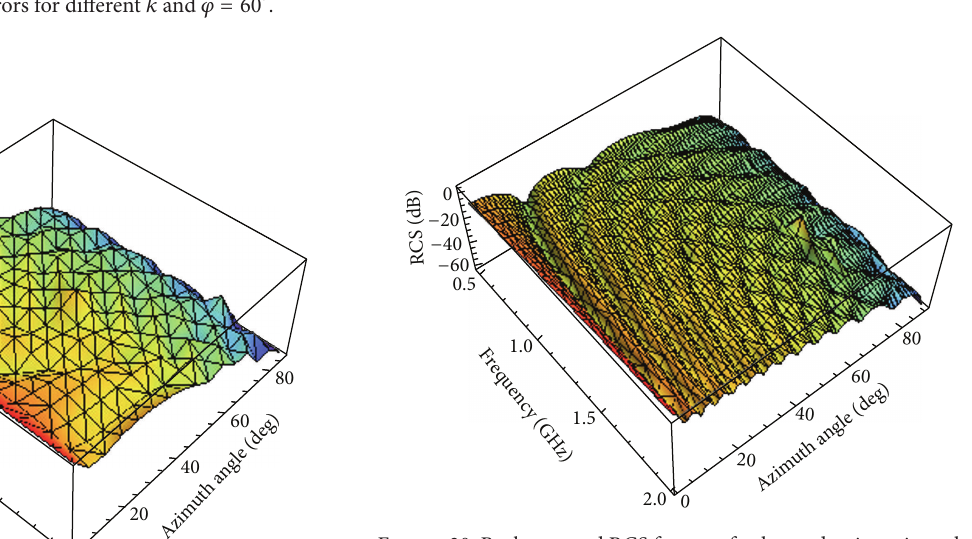
Figure 20: Backscattered RCS for a perfectly conducting triangular flat plate for 𝜃 and frequency of ̂𝑚 =